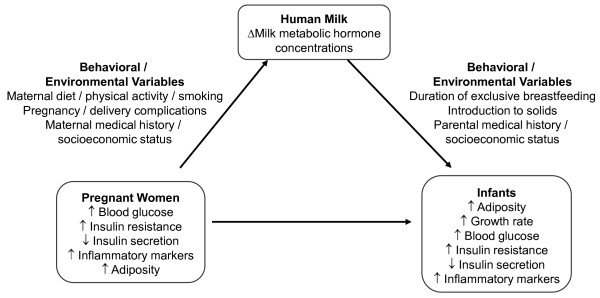
Conceptual model.